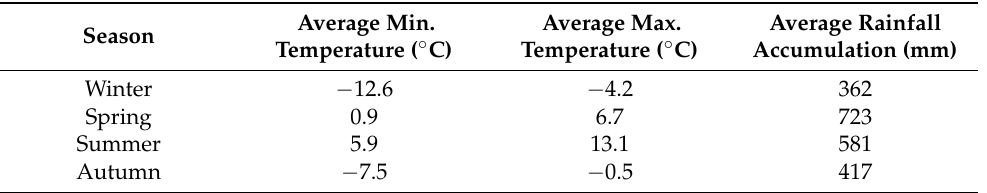
Table 1. Seasonal climatic data obtained from Livigno meteorological center (Italy) and selected for each season simulation in the climatic chamber ARALAB FITOCLIMA 500EC45. Average Min. Average Max. Season